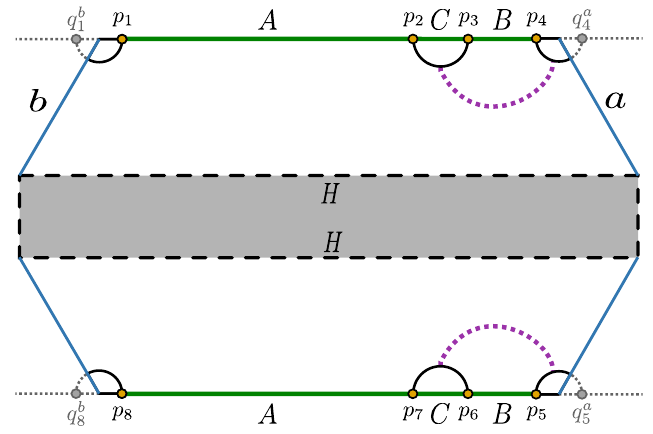
Figure 24 . The endpoints of the intervals A and B and the image points in the two BCFT 2 copies are identified similarly as in figure